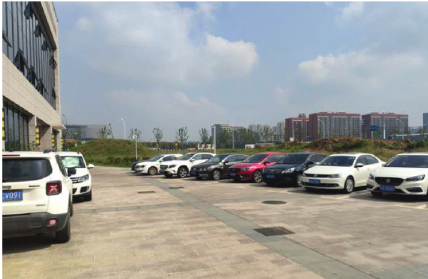
Figure 21: A typical unstructured environment.